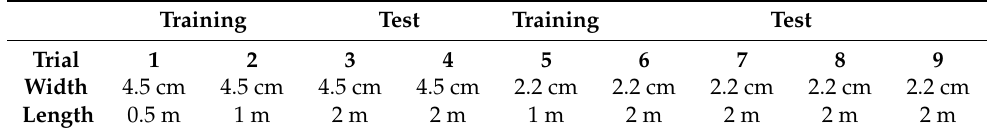
Table 2. Design of the beam walking